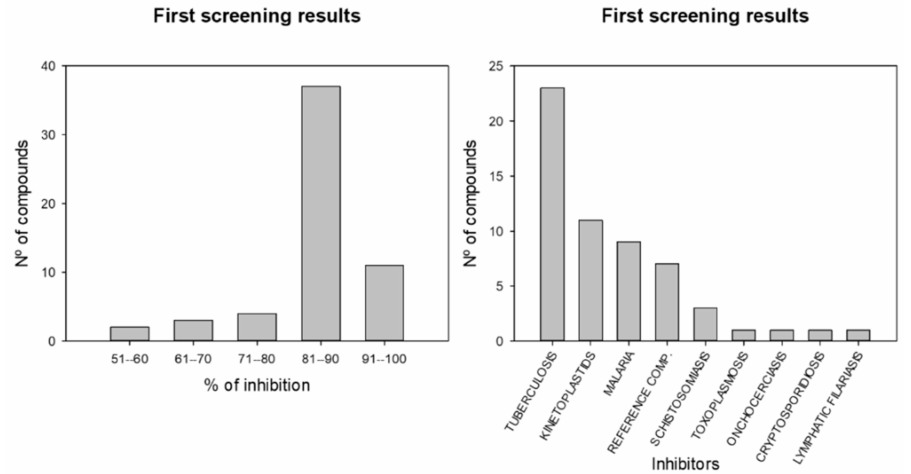
Figure 1. Results of the first screening from the 400 molecules. Data represent the molecules that induce an inhibition of the parasite of higher than 51% at 10 µ M. First graph englobes molecules by their percentage of inhibition against L. amazonensis , and second graph divides molecules by their biological